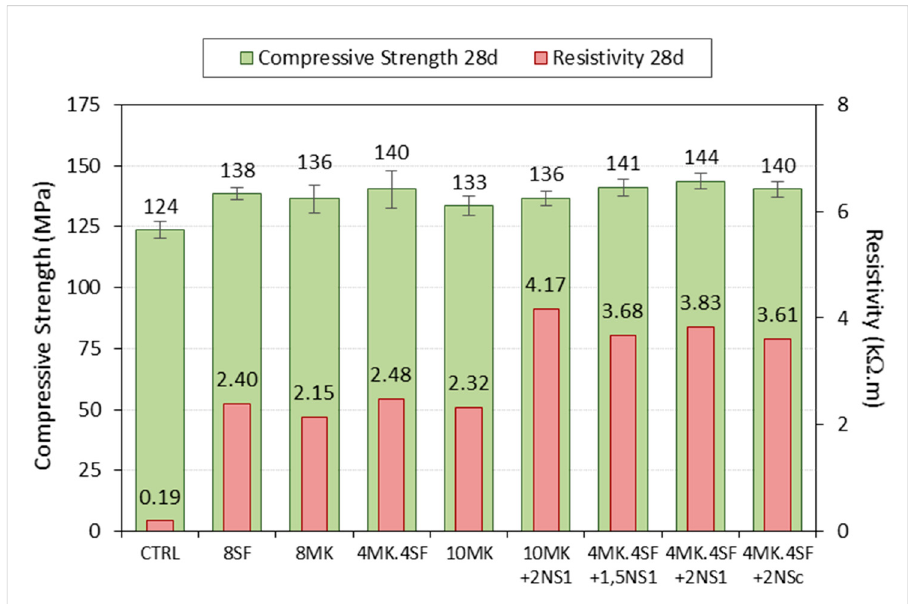
Figure 12. Influence of additions and nano additions on resistivity and compressive strength.